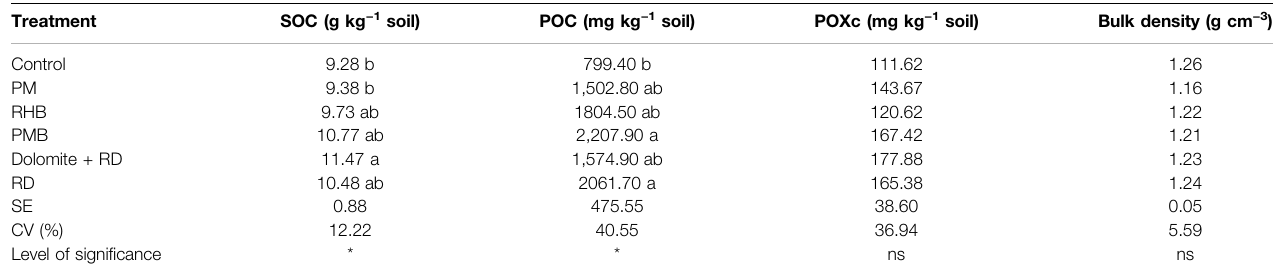
TABLE 3 | Effects of different treatments on SOC, POC, POXc and bulk density at Madhupur and Islampur sites at a depth of 0 – 15 cm. Madhupur site